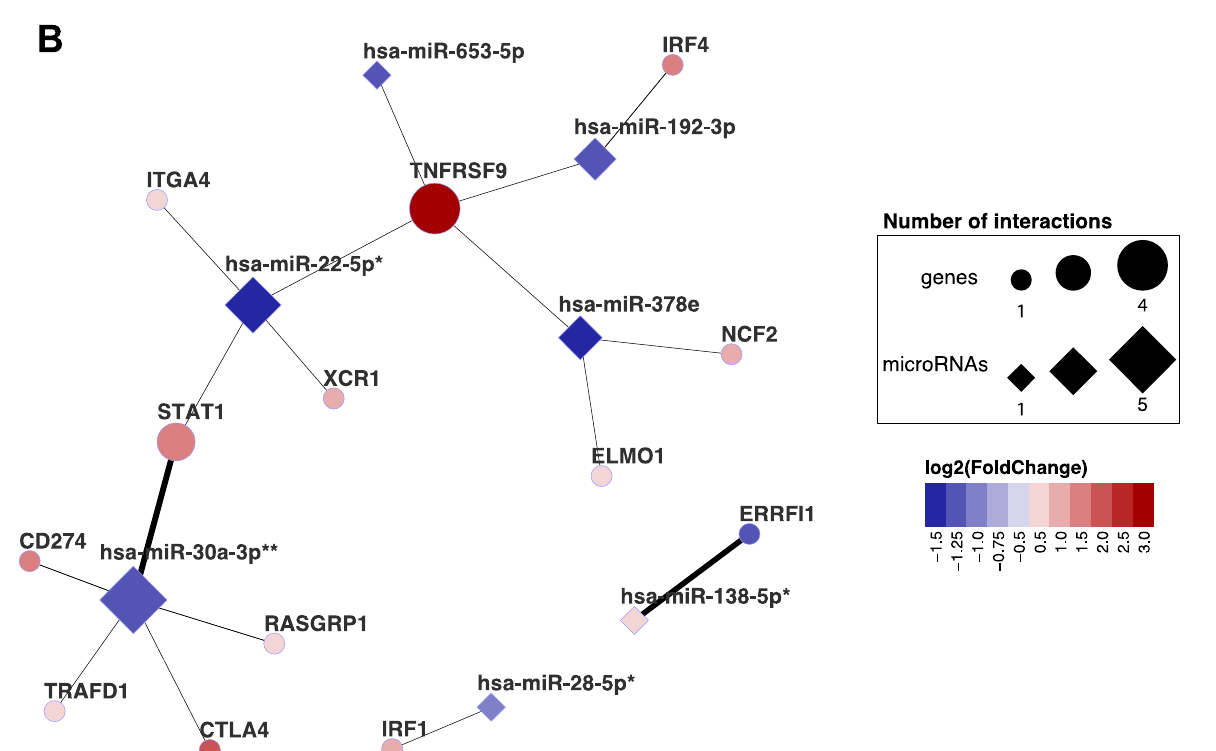
Figure 6. Overlap between genes of which the expression is affected by both celiac disease risk–SNPs and by miRNAs. ( A ) Single sample enrichment analysis reveals that the genes prioritized by van der Graaf et al. are enriched in active CeD compared to controls [9]. This analysis included the 102 genes (out of 118) with sufficient expression in the biopsy transcriptome dataset. Mann-Whitney U p -value: * 0.01–0.05. ( B ) Subset of the miRNA-target transcript interaction network. Only genes that overlap with the prioritized CeD genes are displayed. Thick connecting lines indicate that the interaction was previously experimentally validated. After correction for cell type composition (miRNA-based enrichment score for intestinal epithelial cells and CD3+ cells), the miRNAs indicated with asterisk still show a trend between CeD and controls (FDR: * 0.05–0.1, ** <0.05).